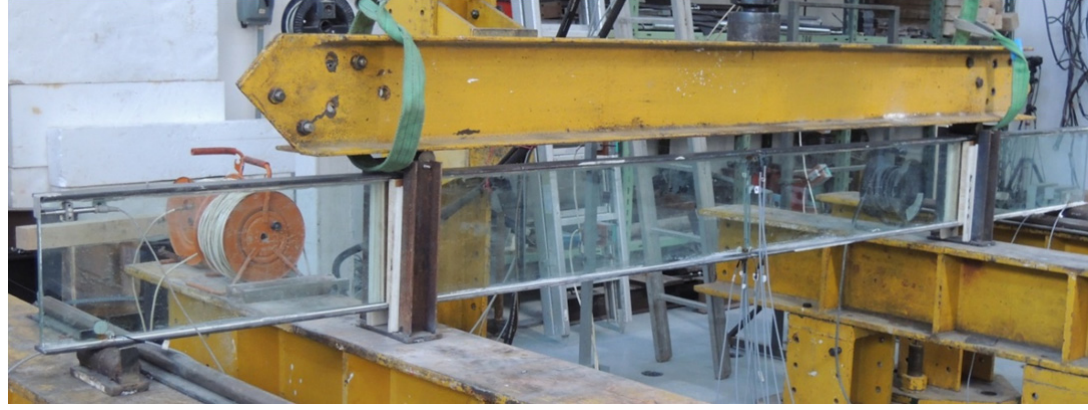
Fig. 12 Hybrid steel-glass beam with SikaFast-5211 NT.